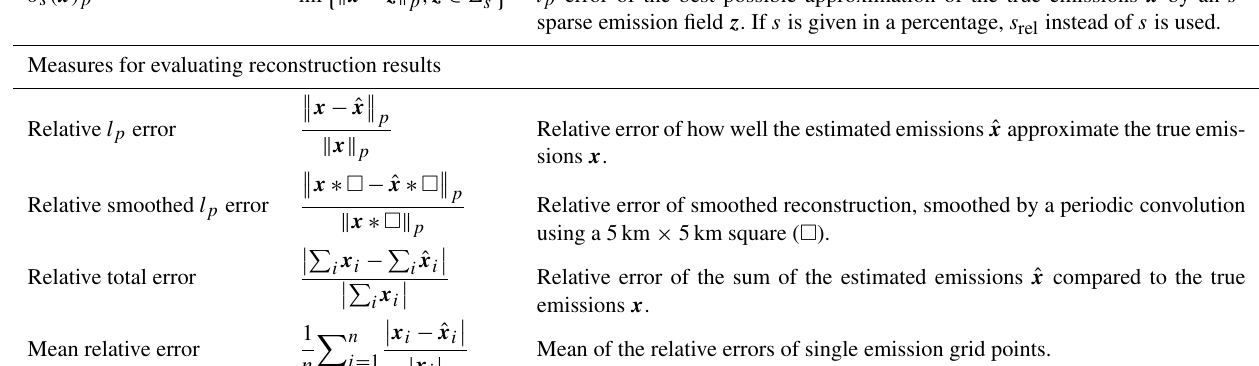
Mean of the relative errors of single emission grid points.